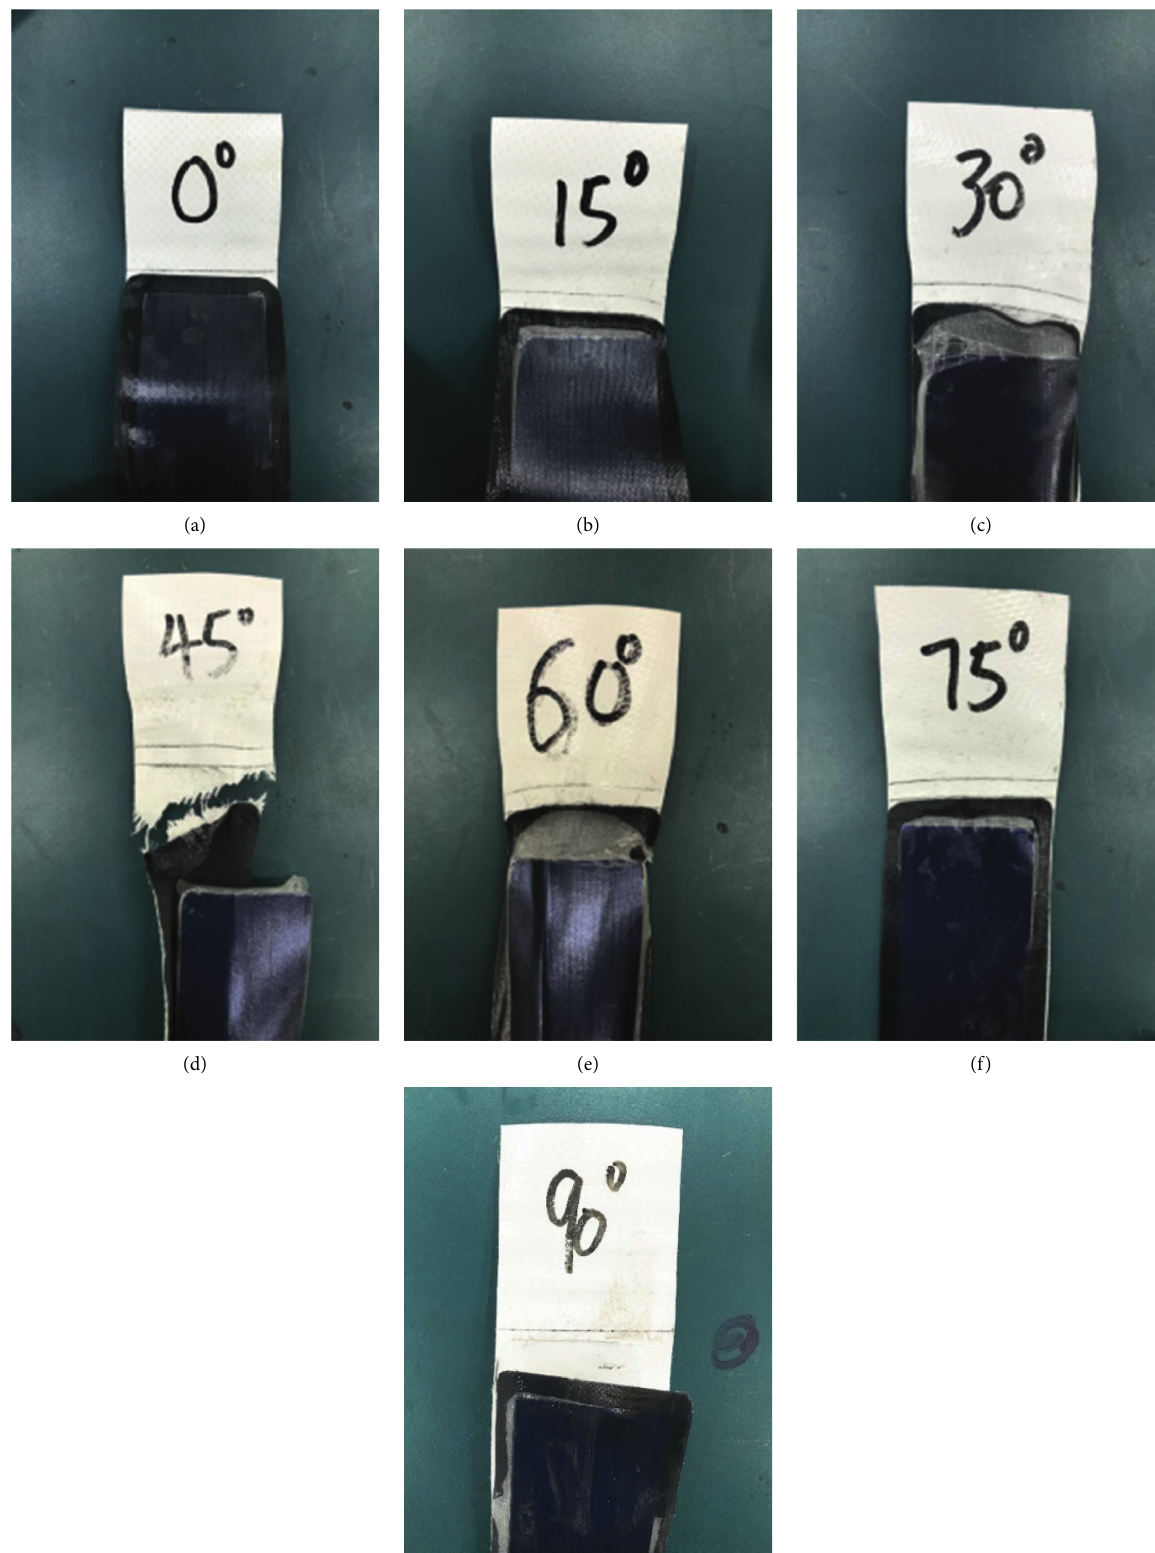
Figure 15: Failure modes of strip specimens. (a) 0 ° . (b) 15 ° . (c) 30 ° . (d) 45 ° . (e) 60 ° . (f) 75 ° . (g) 90 °